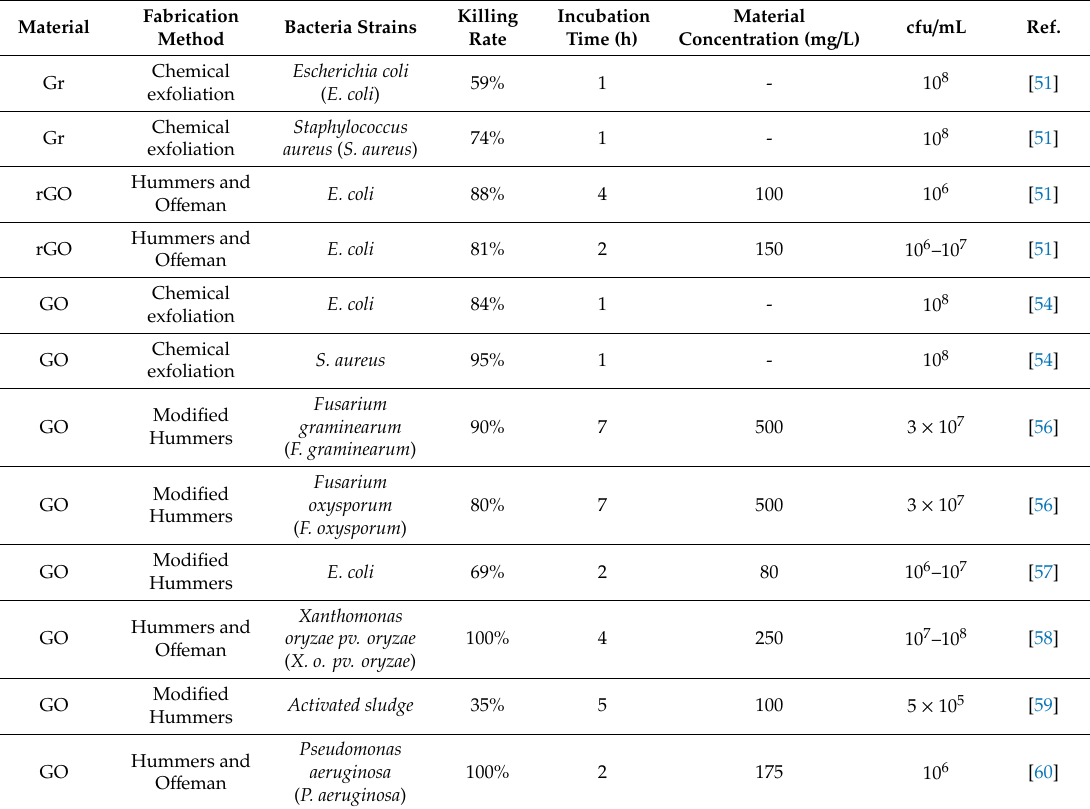
Table 1. The antibacterial e ff ect of the single-graphene family of nanomaterials (GFNs) on